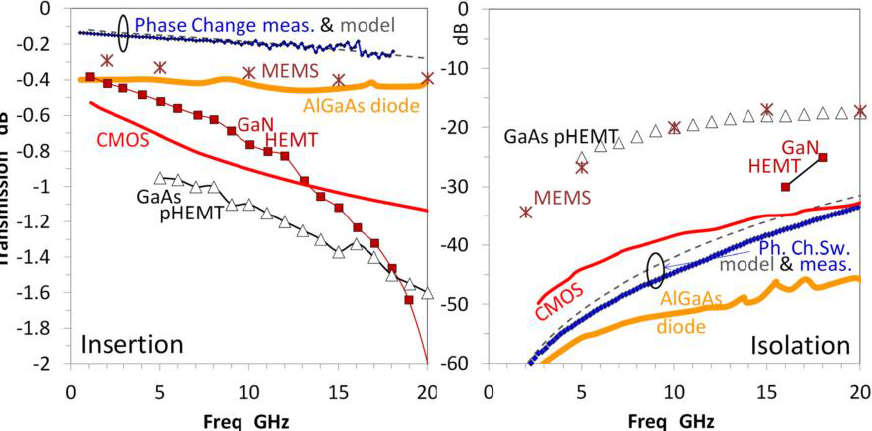
Figure 2. RF performance comparison between various RF switch technologies [11].